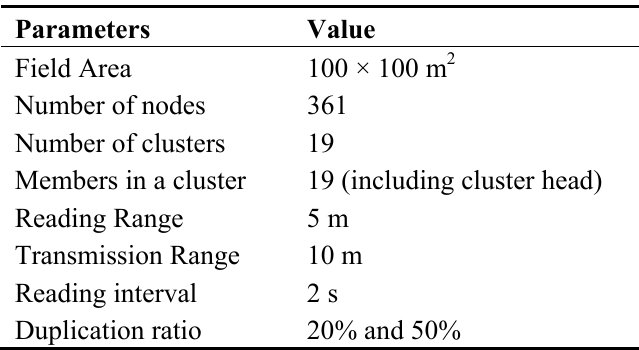
Table 5. Simulation